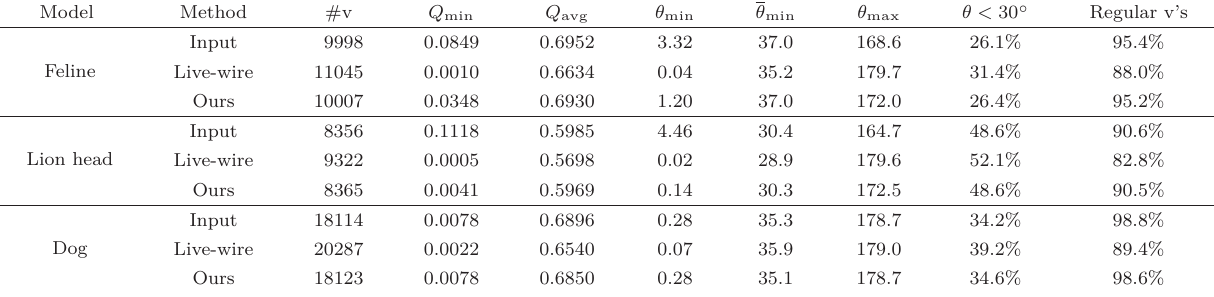
Fig. 6 Segmentation results. Left: Live-wire segmentation. A number of small triangles are created near the curve. Middle: Initialization for our method: Live-wire curve plotted over the input mesh. Blue faces are unlabeled. Right: Our segmentation. These faces become labeled with a minor change in mesh structure. Table 1 Quantitative results for mesh segmentation and comparison with Live-wire [7]. Our method creates fewer additional faces with minimal change to the input mesh quality. #v represents total number of vertices and regular v’s shows percentage of regular